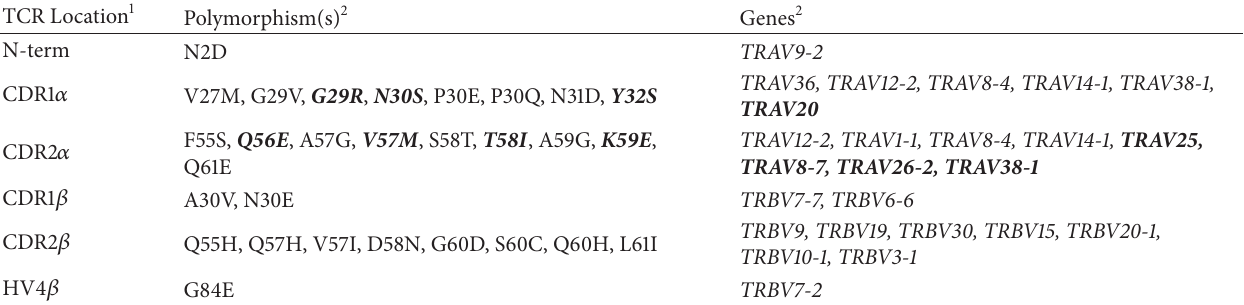
Table 2: Previously identified polymorphisms in TRAV/TRBV genes near the pMHC interface.